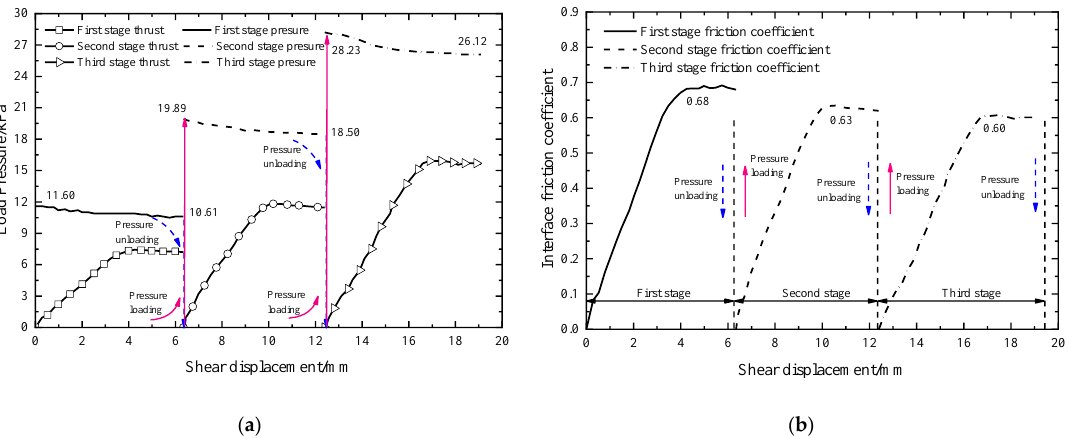
Figure 9. Interface shear test results of T R7d group: ( a ) Load displacement curve of T R7d group and ( b ) Friction coefficient displacement curve of T R7d group.